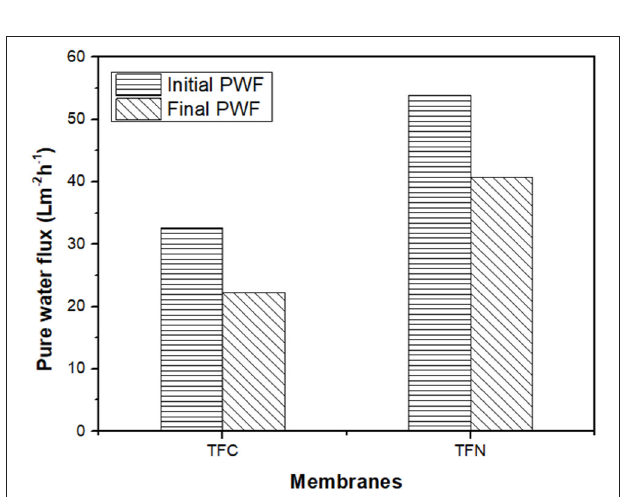
FIGURE 11 | The pure water flux for TFC and TFN 2 before and after CTAB filtration.